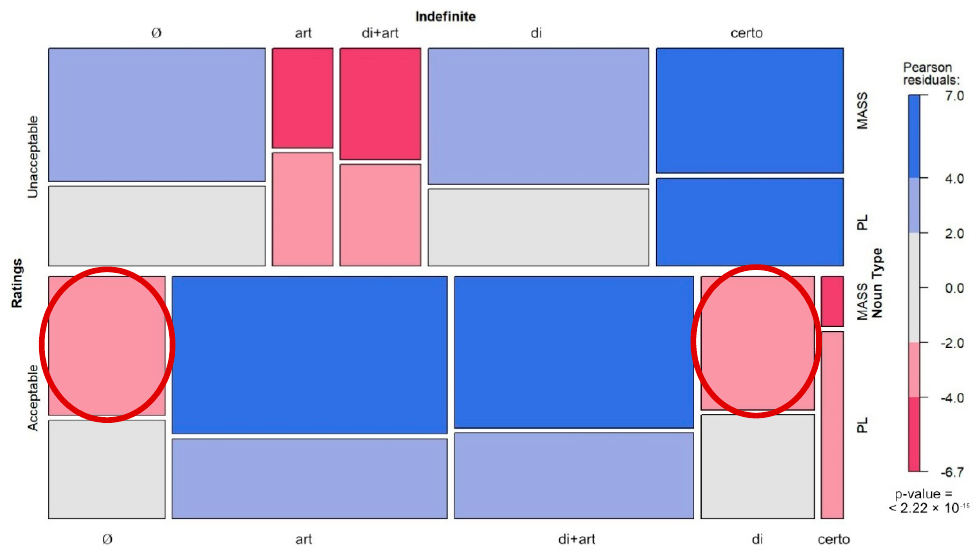
Figure 5. (Un)acceptability rate of each indefinite determiner with mass and plural nouns. The two red circles highlight the minor acceptability for ZERO and bare di with mass nouns.